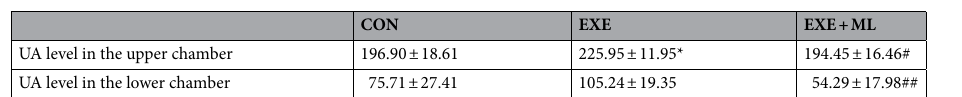
Table 4. UA level in culture plate in the upper and lower chamber (μmol/L). *Significantly different from CON ( p < 0.05). #Significantly different from EXE ( p < 0.05). ##Significantly different from EXE ( p < 0.01).